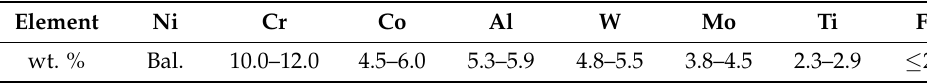
Table 1. The alloy composition of K3 nickel-based superalloy.